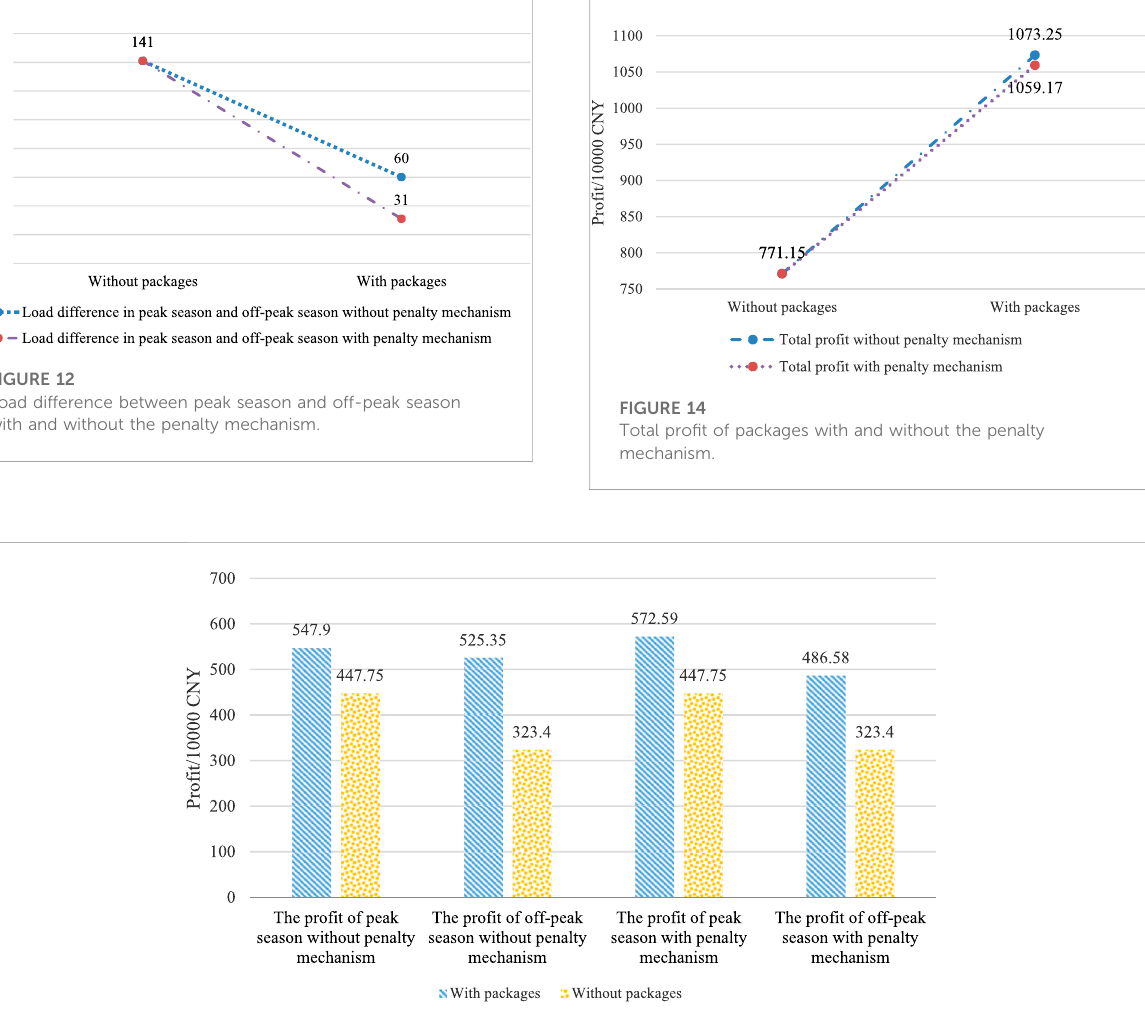
FIGURE 13 Peak season and off-peak season pro fi ts with and without the penalty mechanism.